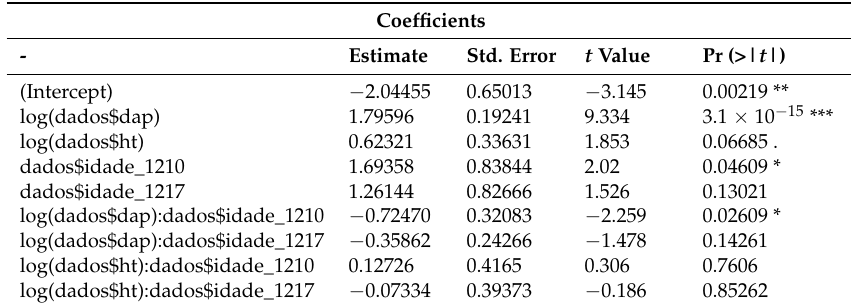
Table A8. R software output table with significance values resulting from ANCOVA for AGDM using C 12 as reference for comparison with C 10 and C 17.